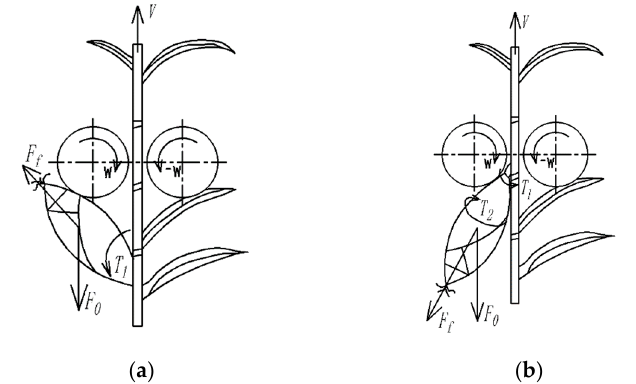
Figure 7. Ear picking process of the picking device. ( a ) The initial stage of the work; ( b ) The second stage of the work.